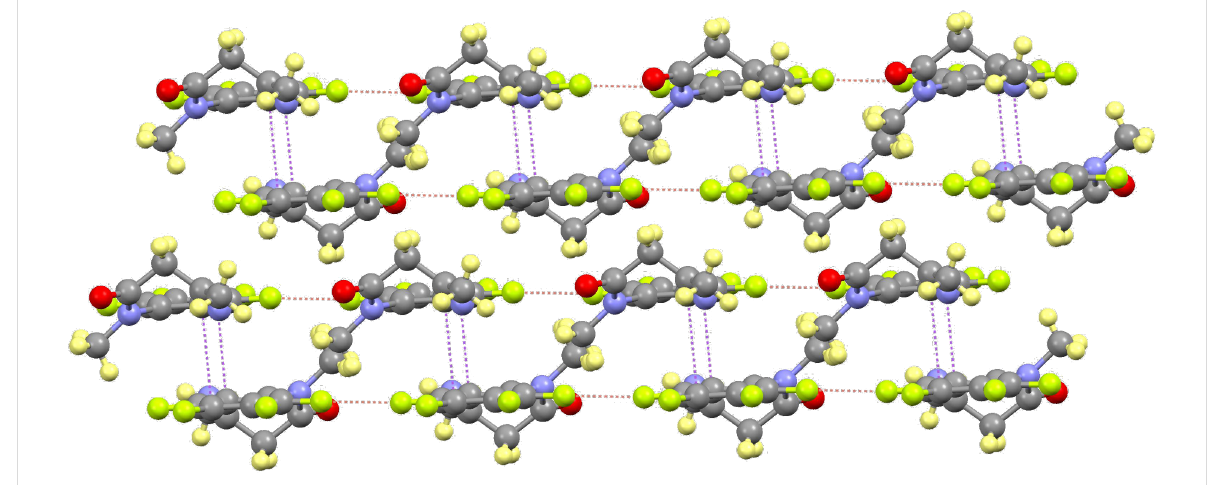
Figure 6: Packing of 2 showing the F–F contacts along the chain (orange) and the π – π interactions that form the double chain (violet).